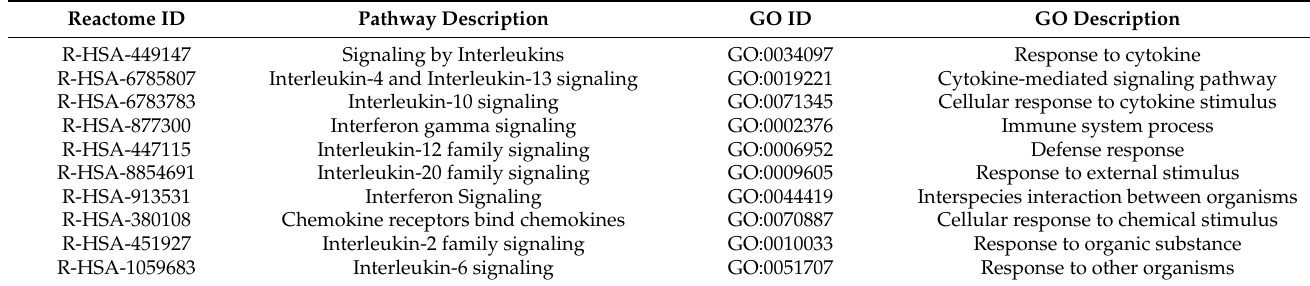
Table 4. Top 10 enriched pathways and a gene ontology of 426 genes associated with skin diseases with alterations in the Notch signaling